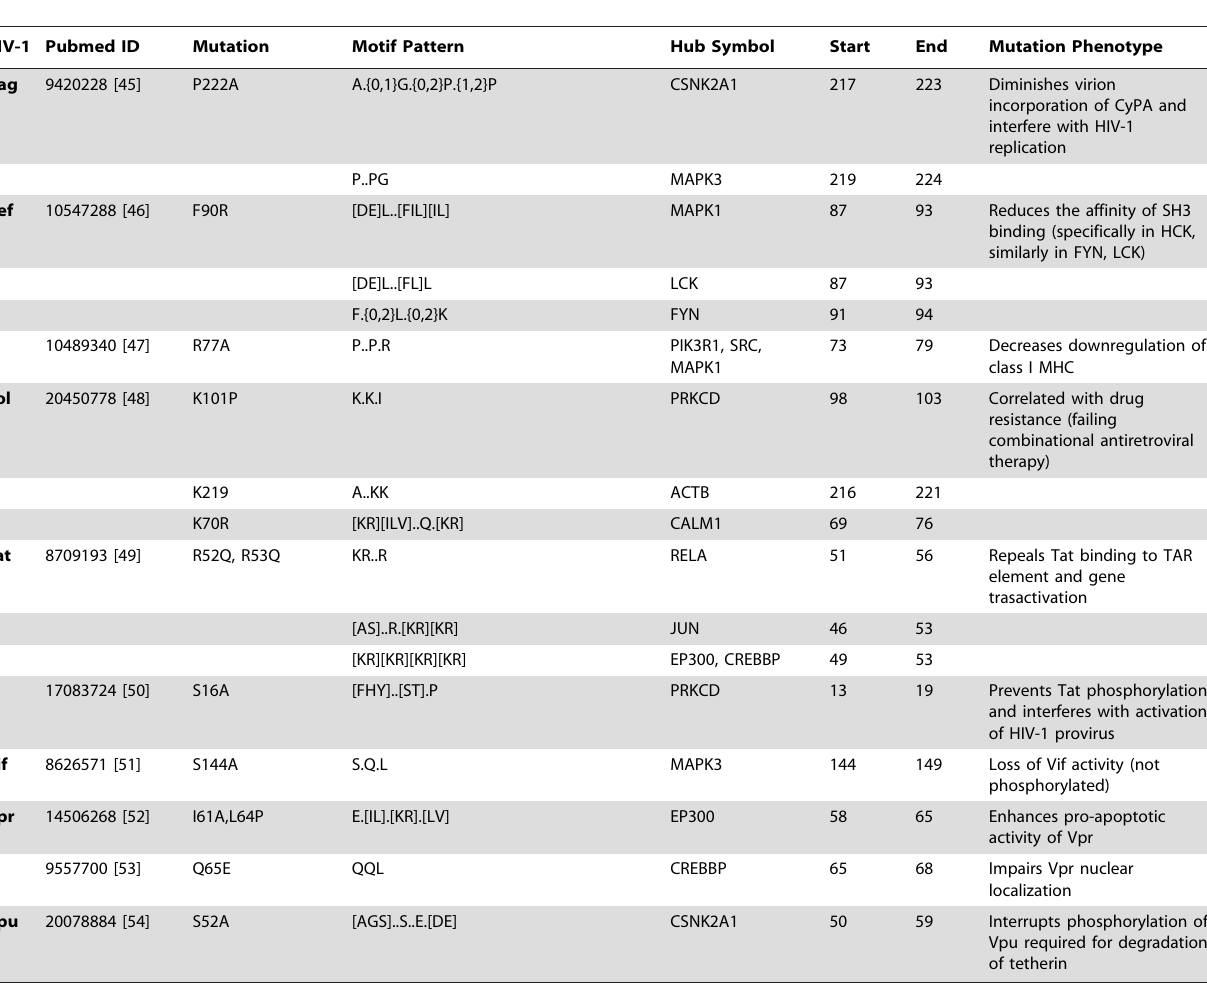
Table 3. Directed mutations of HIV protein sequence in research literature within the range of motifs annotated in this study.